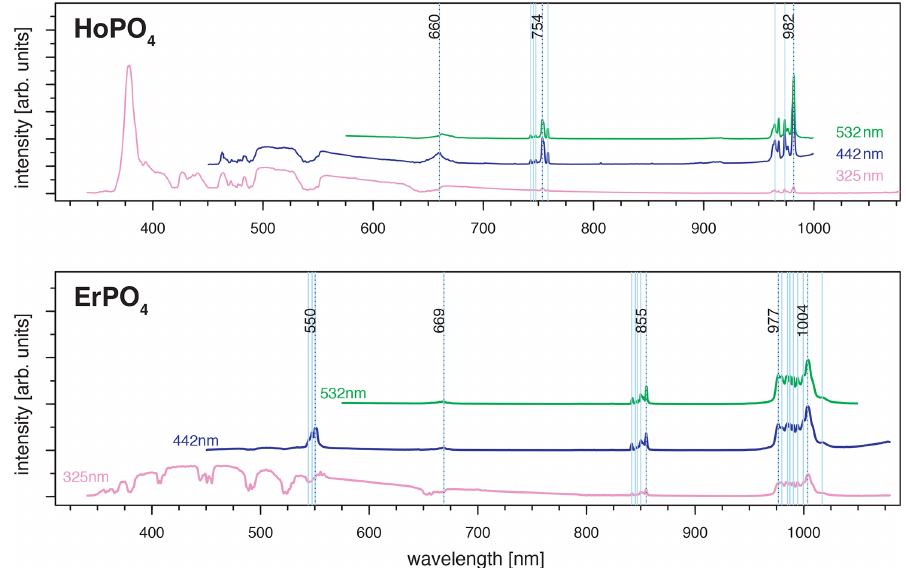
Figure 9. Evaluation of suitable laser wavelength for efficient REE excitation without unspecific broad-band luminescence (examples HoPO 4 and ErPO 4 ) (dotted black lines: major emissions within emission cluster; light blue lines: emission